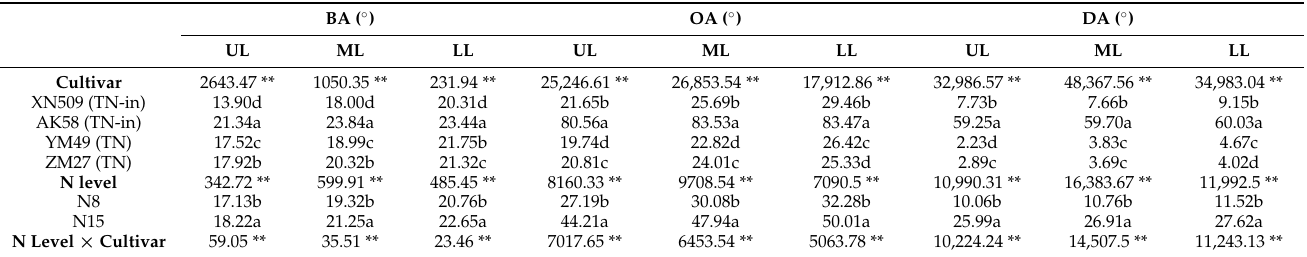
Table 4. The leaf angle vertical distribution in two N-efficient and two N-inefficient winter wheat varieties under different levels of N.